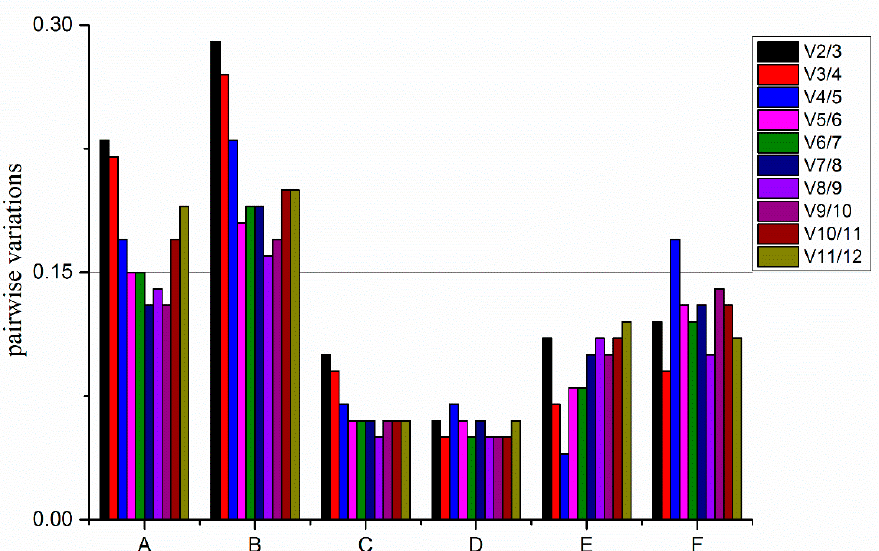
Figure 5. Determination of the optimal number of reference genes for different sample groups using geNorm. ( A – F ) represent different sample groups. ( A ) in 24 sample groups, ( B ) in different tissues, ( C ) at different times after pollination, ( D ) in styles at 4 h aftecross/self-pollination, ( E ) at different stages of flowering, and ( F ) in male catkins at different stages of elongation.